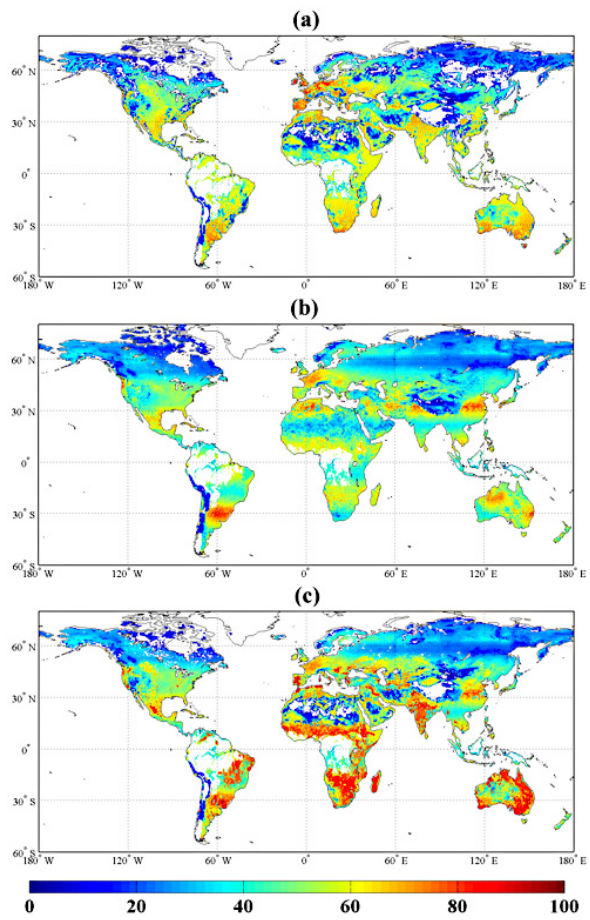
Fig. 12. Temporal coverage (i.e., fraction of days with observa- tions) of (a) original AMSR-E, (b) original ASCAT and (c) merged product, for